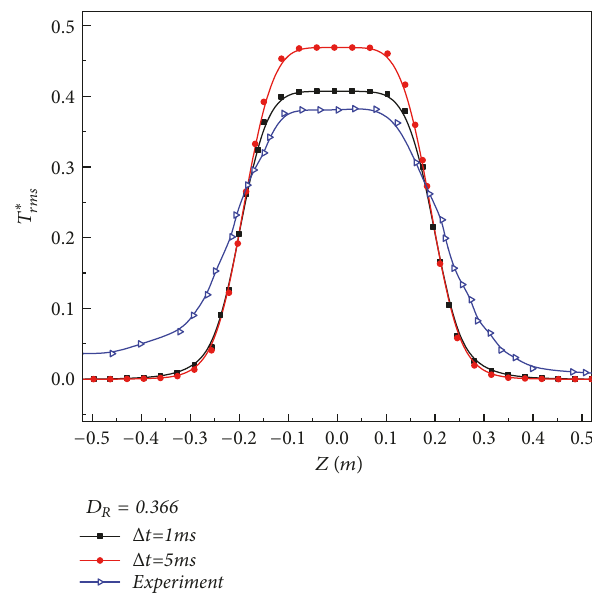
Figure 9: Comparison of dimensionless RMS velocity between the experimental value and the simulated value in different time steps.